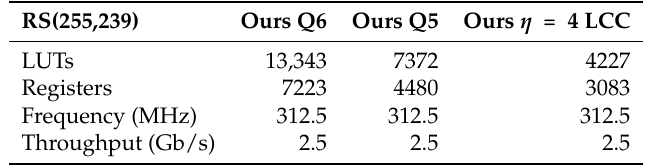
Table 4. Implementation results of RS decoders in a Virtex-7 FPGA